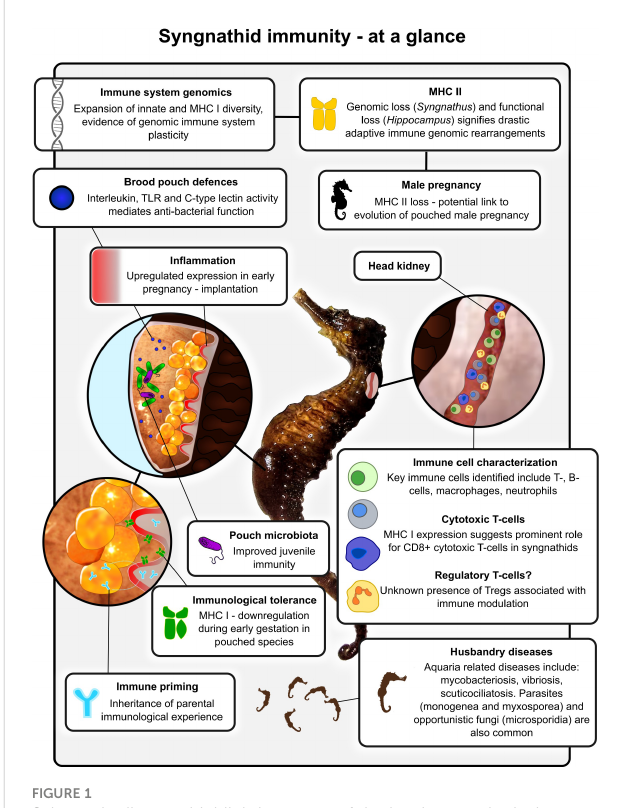
FIGURE 1 Schematic diagram highlighting some of the key immunological characteristics and research fi ndings associated with syngnathid fi